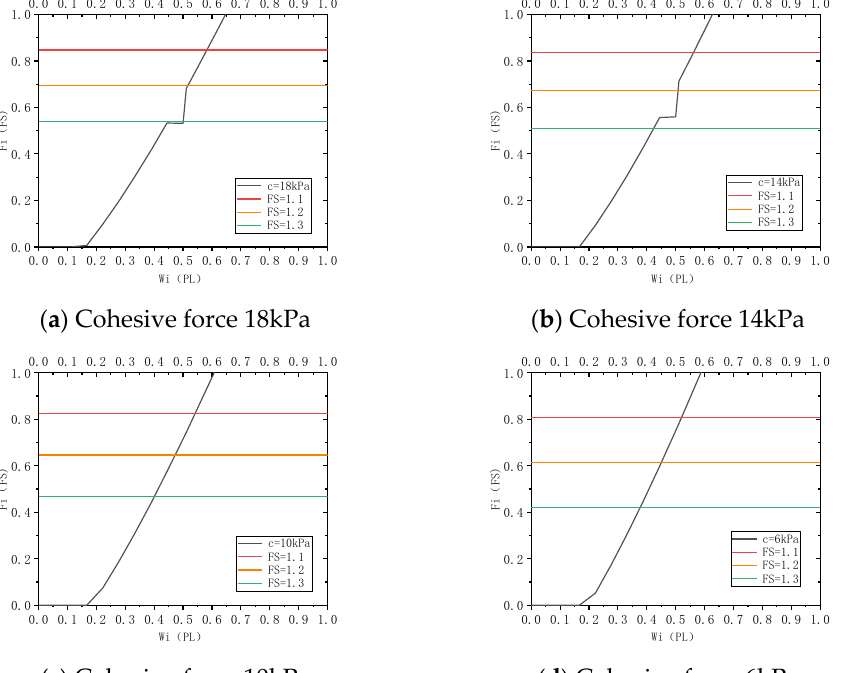
Figure 10. Landslide early warning model for ion-adsorption rare earth with a slope of α 30°.